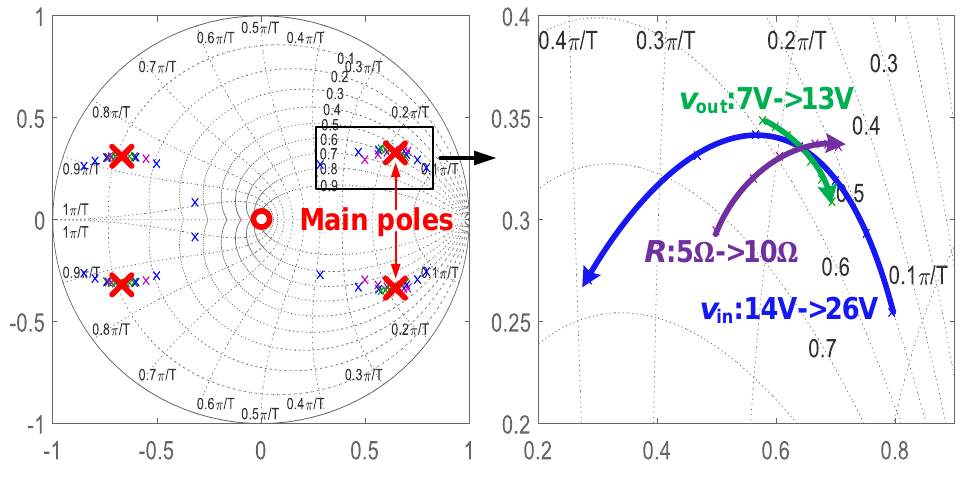
Figure 11. Zeros and poles of F vr ( z ).